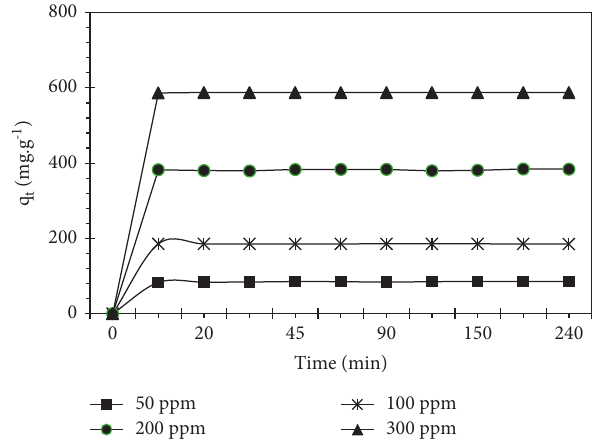
Figure 4: Influence of contact time at various initial concentration on CR removal by fish bone powder (FBP) (adsorbate: 100mL;